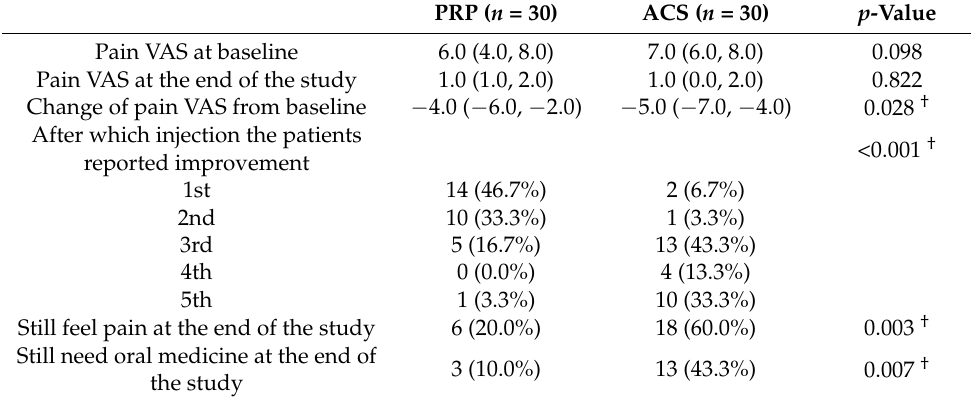
Table 2. Outcomes of PRP or ACS treatment in patients with Stage III osteoarthritis of the